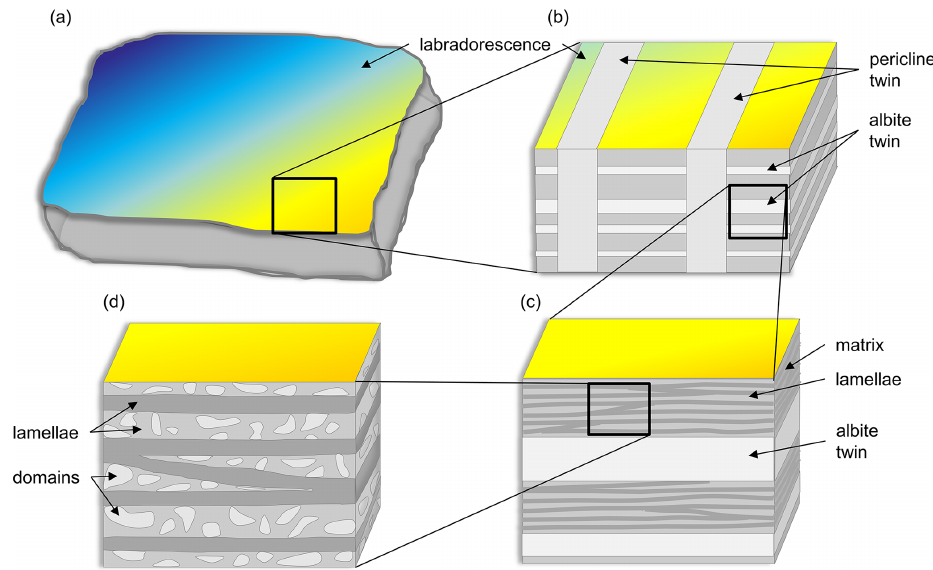
Figure 3. Not-to-scale schematic drawing of the different structures in labradorite. (a) Macroscopically, the labradorescence, ranging from dark blue to yellow, can be seen. Panel (b) represents a magnified view from (a) . Here, the albite (0.2–1µm) and pericline twins ( ∼ 200µm) are shown. (c) Magnifying the area around the albite twins even further reveals the presence of alternating thicker and thinner lamellae ( ∼ 100nm) that are approximately parallel to each other and lie in the plane of labradorescence. (d) An even higher magnification additionally showing small domains (20–50nm) being present only in the bigger lamellae.